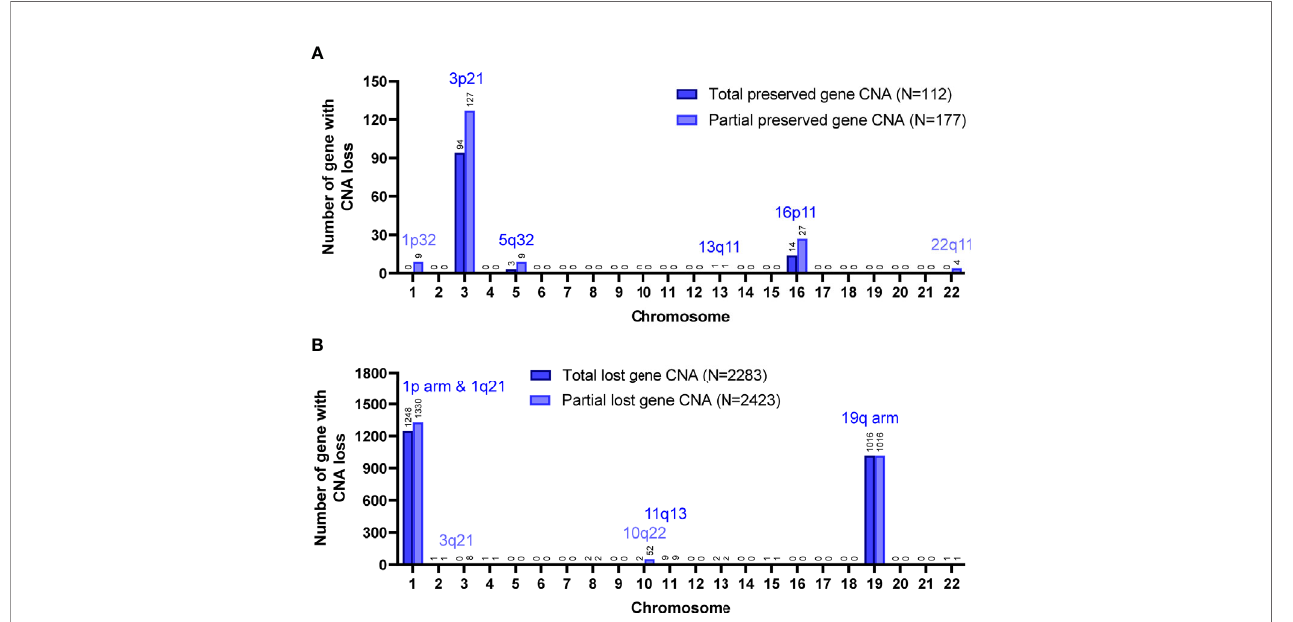
FIGURE 3 | Preservation status of genes with CNA loss in cultured primary cells compared to the parental grade II/III tumors. Total, the CNAs of targeted genes in patient specimens were all preserved/lost in their primary cells. Partial, at least 60% of primary cells preserved or lost the targeted gene CNAs. The chromosome distribution of the preserved (A) or lost (B) gene CNAs in primary